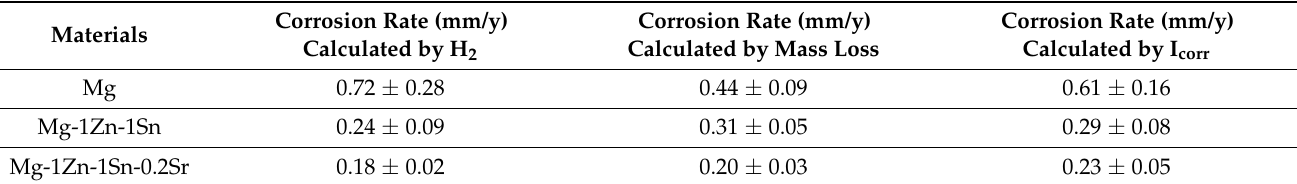
Table 4. The average corrosion rate calculated from H 2 evolution, mass loss and I corr of p-Mg, Mg-1Zn-1Sn and Mg-1Zn- 1Sn-0.2Sr alloys in SBF